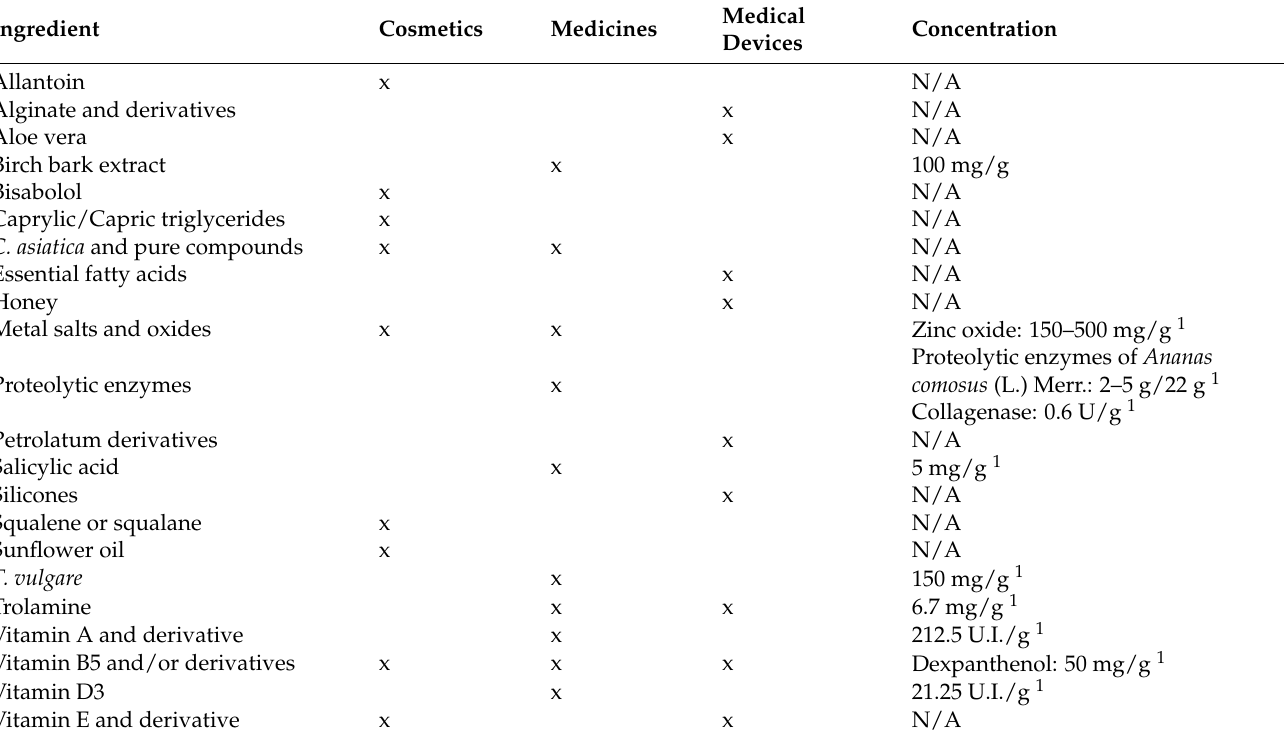
Table 1. Summary of the ingredients found in cosmetics, medicines, and medical